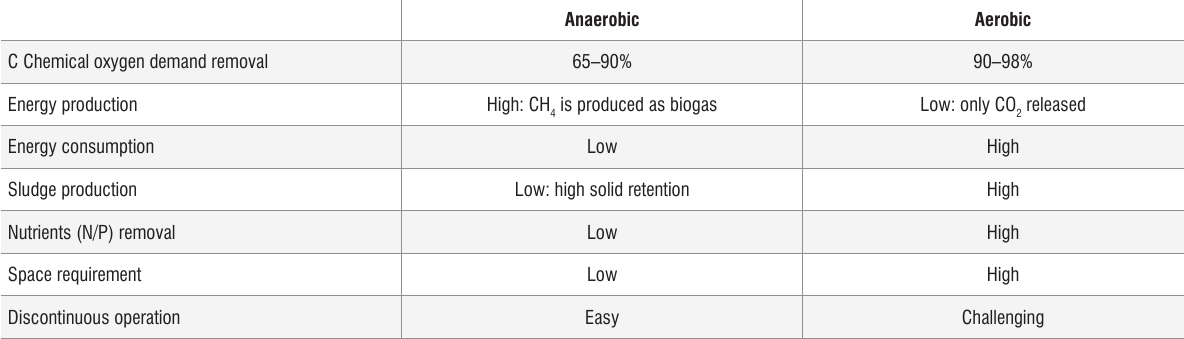
Comparison between anaerobic and aerobic